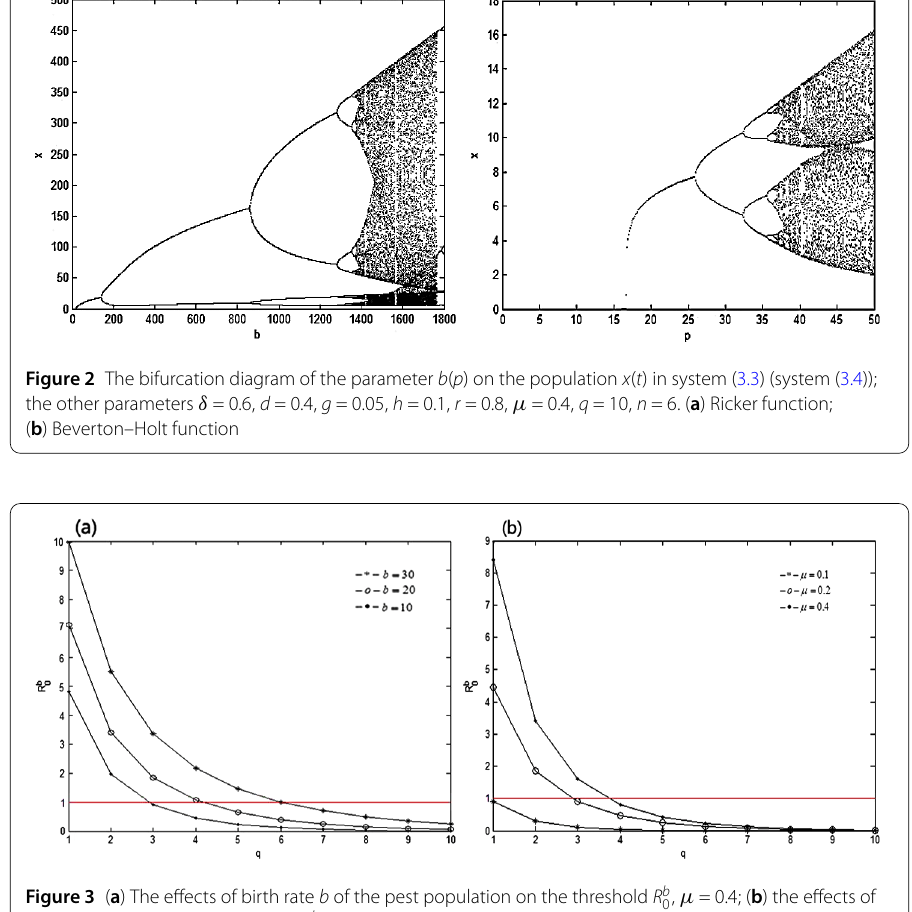
Figure 3 ( a ) The effects of birth rate b of the pest population on the threshold R b 0 , μ = 0.4; ( b ) the effects of pesticide dose μ on the threshold R b 0 , b = 20, other parameters are d = 0.4, δ = 0.6, g = 0.1, r = 0.6, h =